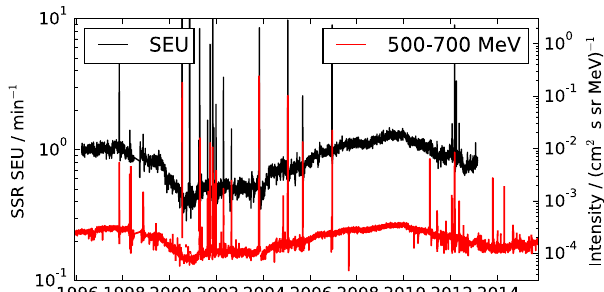
Fig. 6. Single Event upsets recorded by SOHO ’ s solid state recorder and EPHIN measured fl ux of 500-700